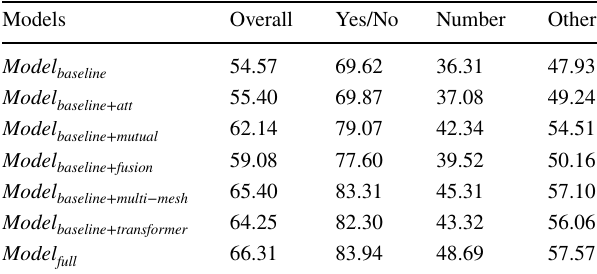
Table 3 Model ablation experiment results on VQA v2 validation set. Model is trained using only the training set and tested on the valida- tion set Models